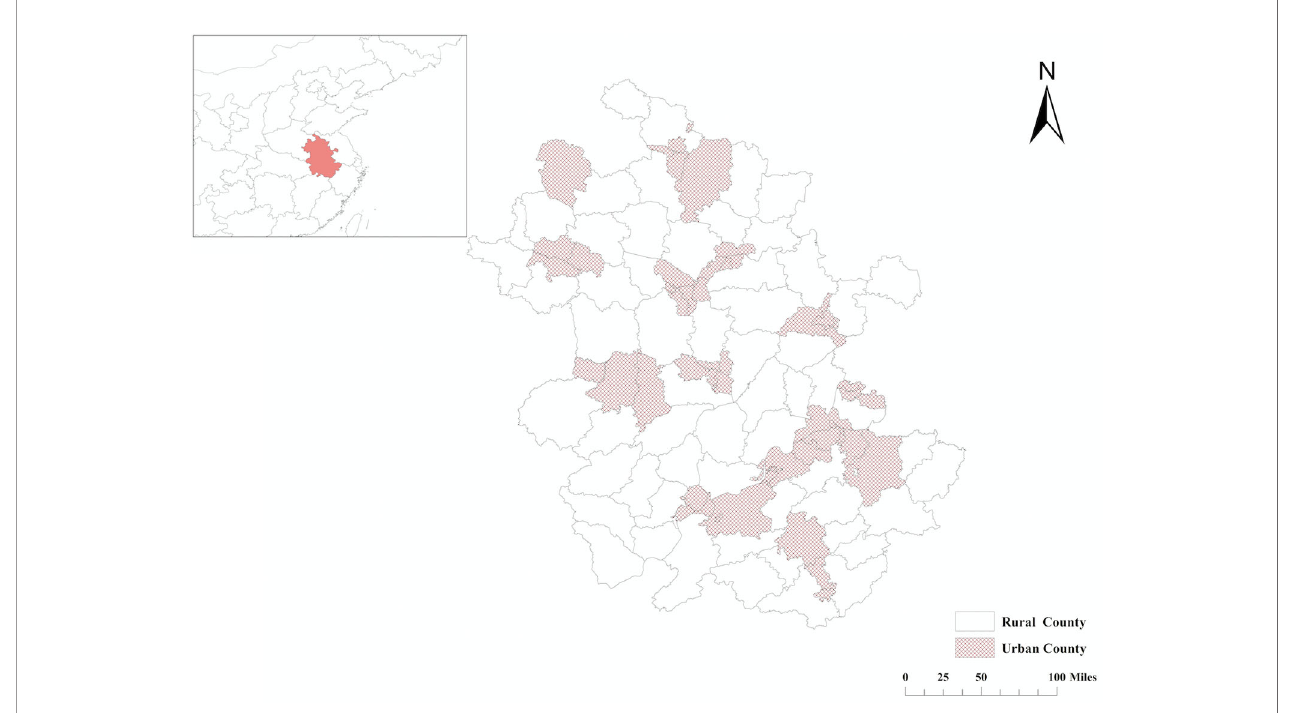
FIGURE 1 | Distribution of urban and rural counties in Anhui Province,